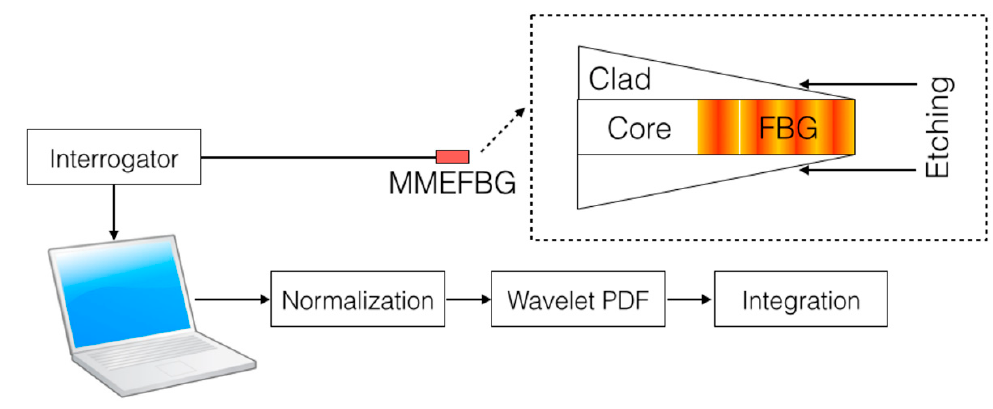
Figure 3. Schematic of the multimode etched fiber Bragg grating (MMEFBG) interrogation system and detection.